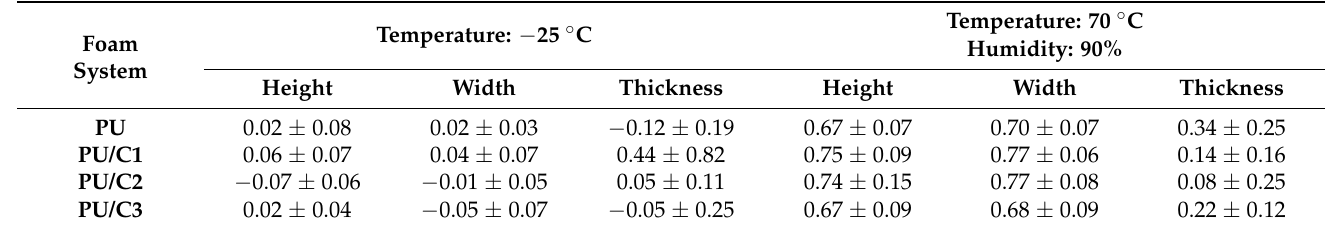
Table 8. Dimensional stability of